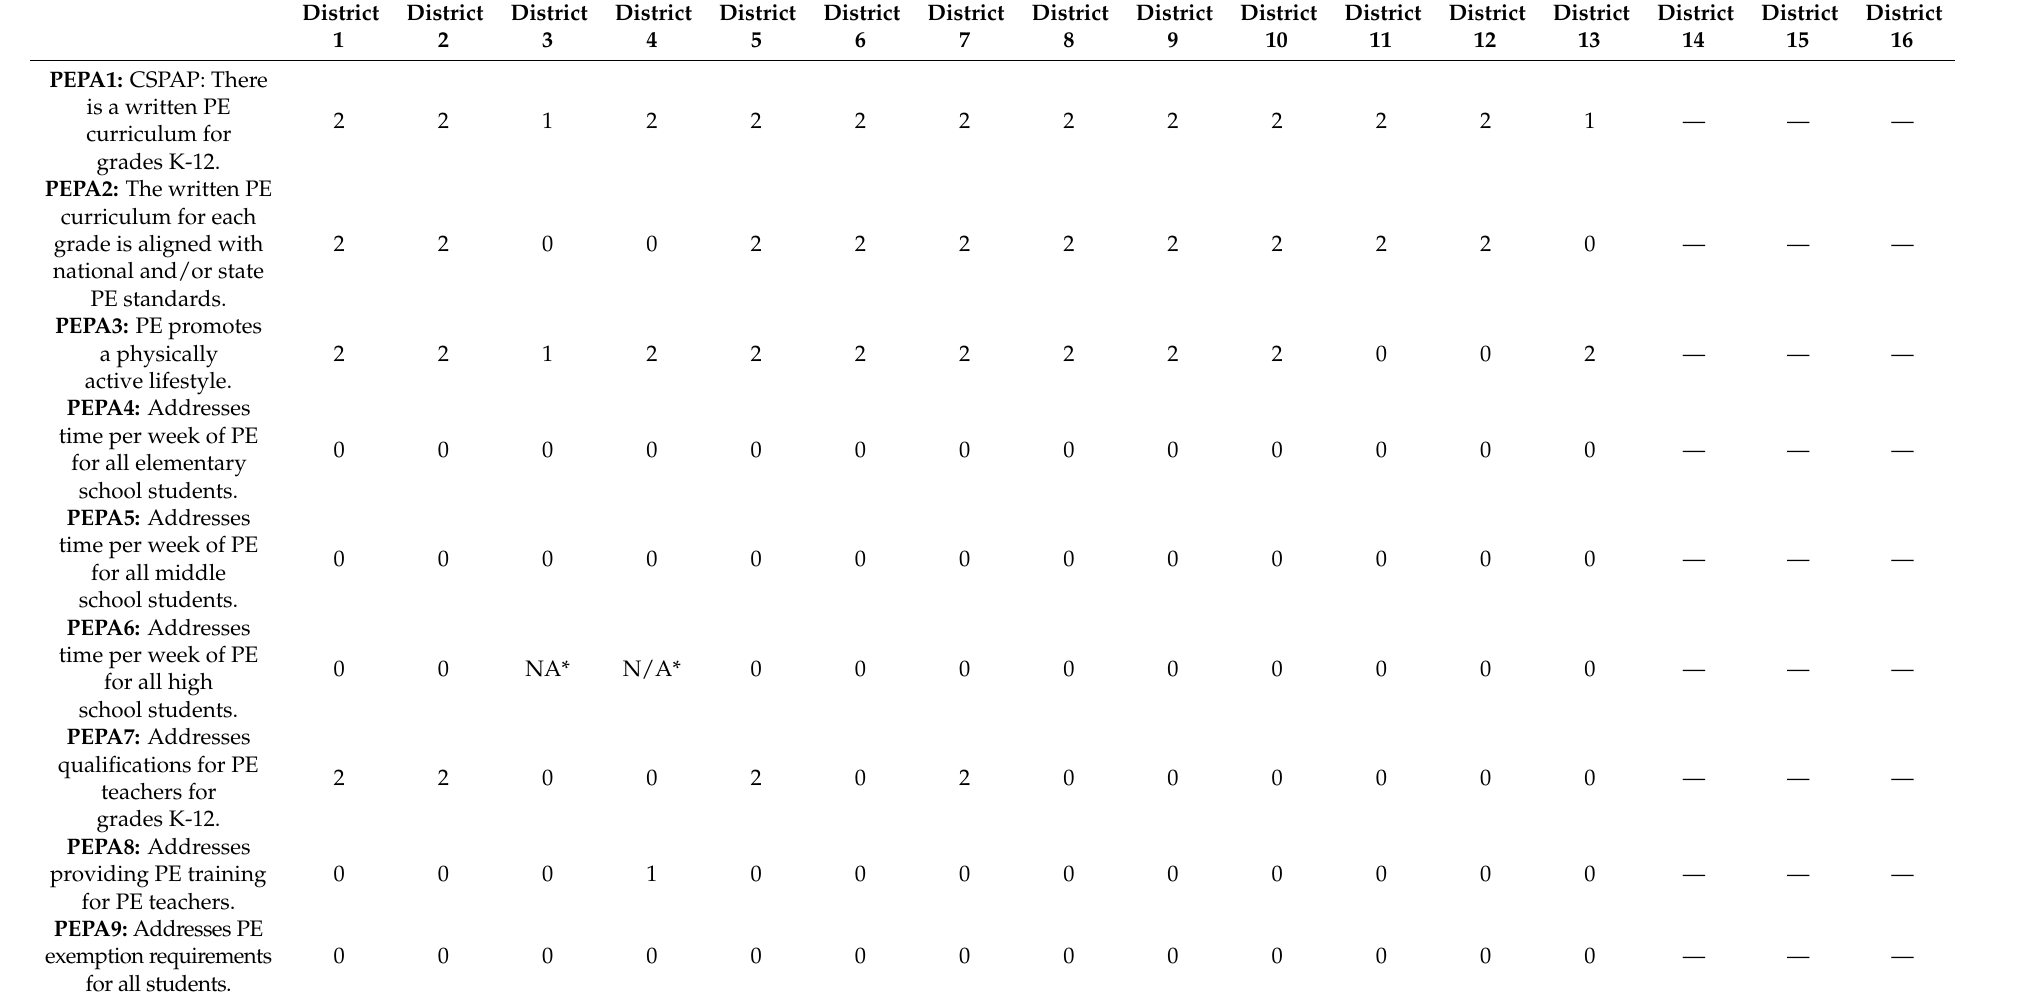
Table 1. WellSAT 3.0 PEPA scores for each district. Scores have been rounded to whole